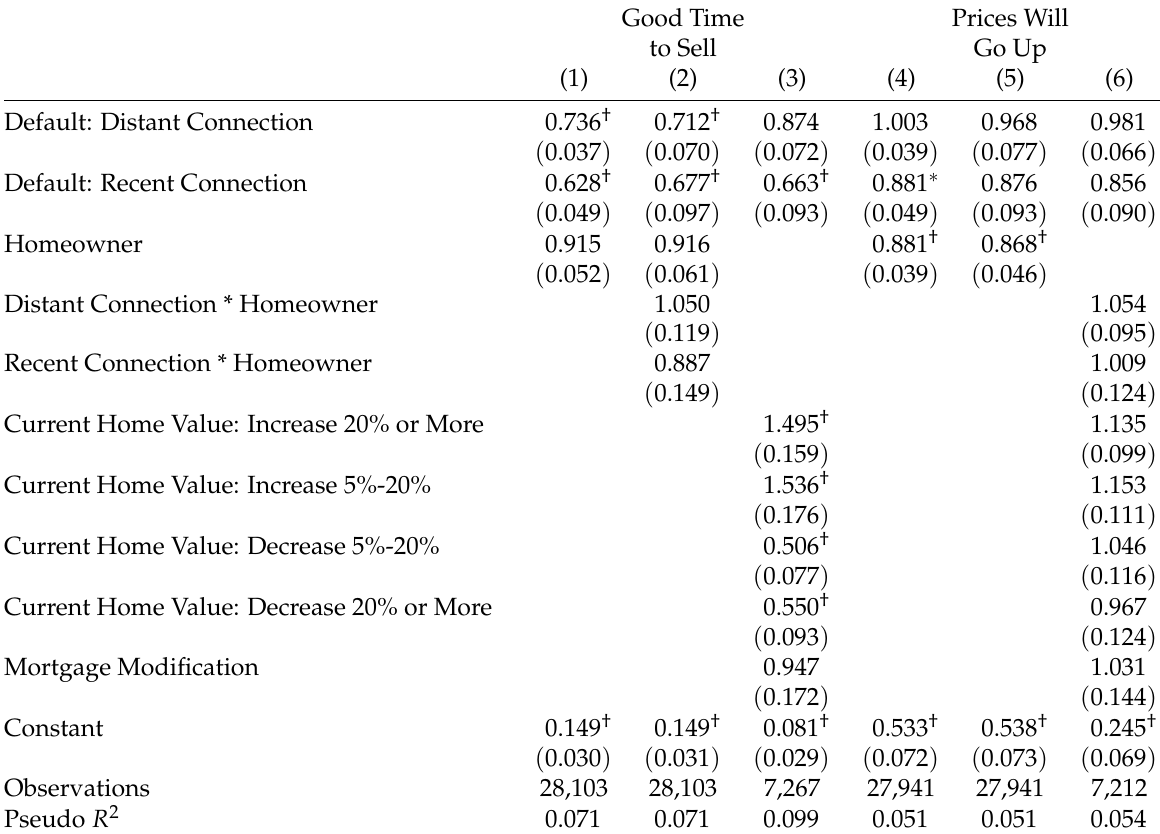
Table 2: Odds ratios from logistic regression of housing market expectations.